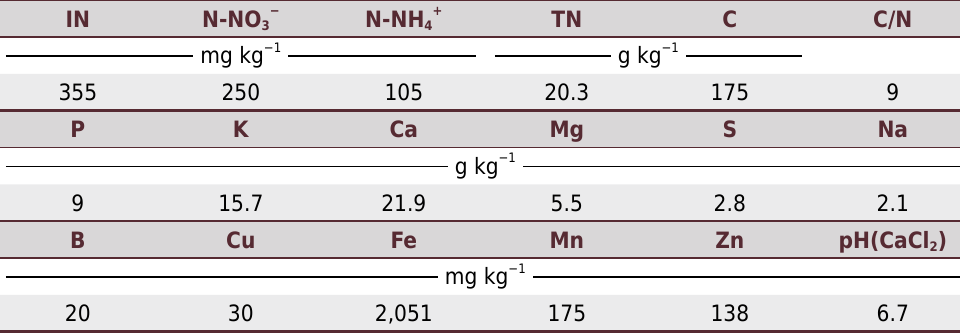
Table 2. Mean values of the chemical properties of the compost IN N-NO 3